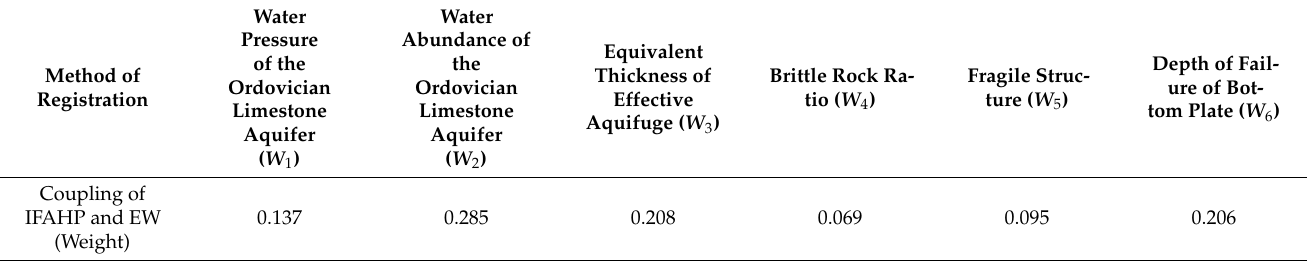
Table 4. Entropy Weight Method to Determine Weight Results of the Main Controlling